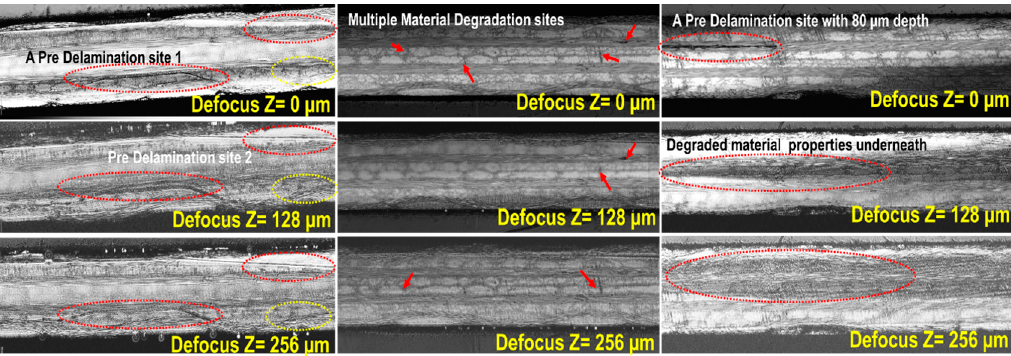
Figure 8. Scanning Acoustic Microscopy (SAM) images from the decommissioned specimen S-A after 300,000 cycles of fatigue loading.